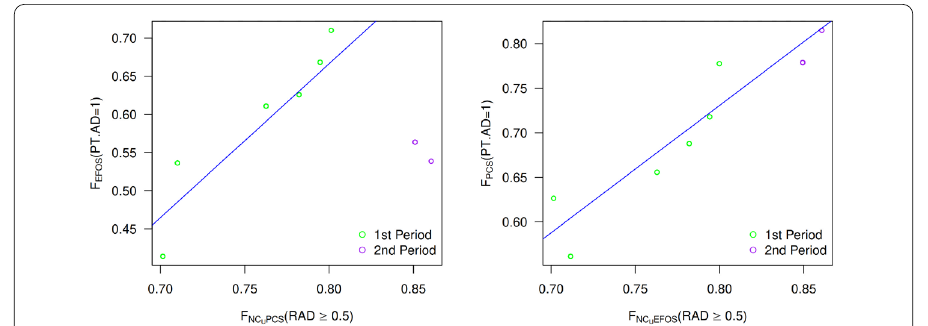
Figure 7 Correlation between RAD and corruption risk. Linear model to correlate the fraction of contracts with RAD ≥ 0.5 per year (as independent variable) with the fraction of contracts by single-bidder per year ( i.e. contracts for which PT.AD = 1), as dependent variable, for the EFOS and PCS classes ( Left and Right , respectively). To avoid trivial auto-correlations, we exclude from the set corresponding to the independent variable the data of the dependent variables. The years corresponding to the 1st period are marked in green, those corresponding to the 2nd period in purple. Since the number of contracts varies widely from one year to another, the data was weighted by the number of contracts in each class per year to perform the least square fit. For the first model (EFOS class) we obtained an R 2 = 0.72, an intercept of –0.94, and a slope of 2.01. For the second model (PCS class) we obtained an R 2 = 0.82, an intercept of –0.41, and a slope of 1.42. All the parameters with p v (cid:6) 0.01